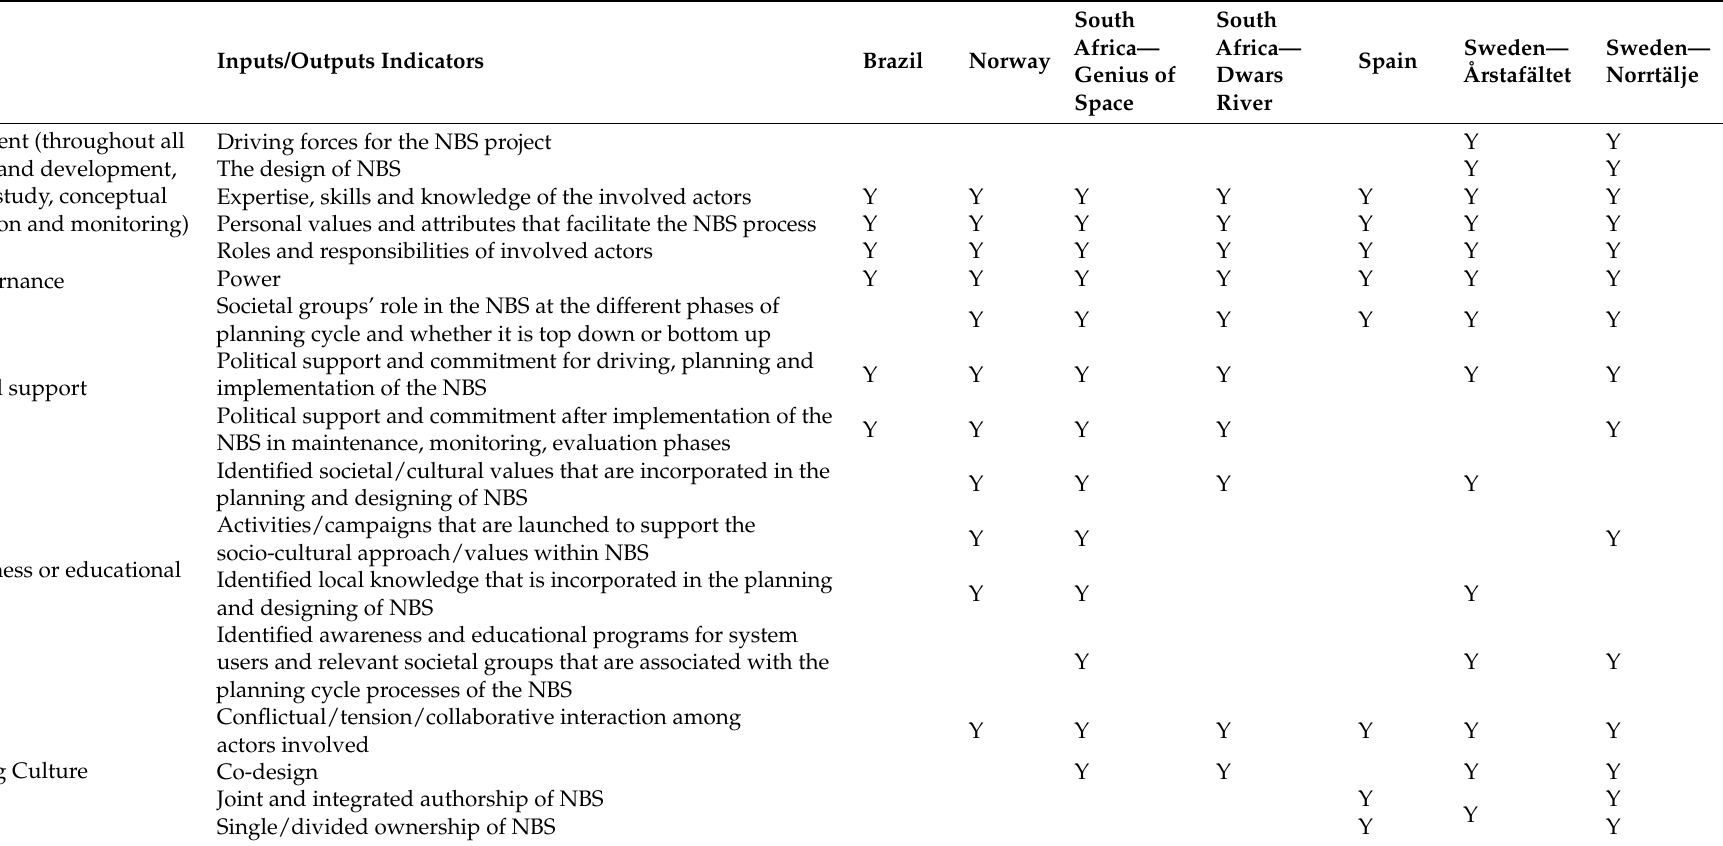
Table 6. Process-based social indicators according to whether each case study considered the indicator as relevant to be assessed (indicated with ‘Y’ for